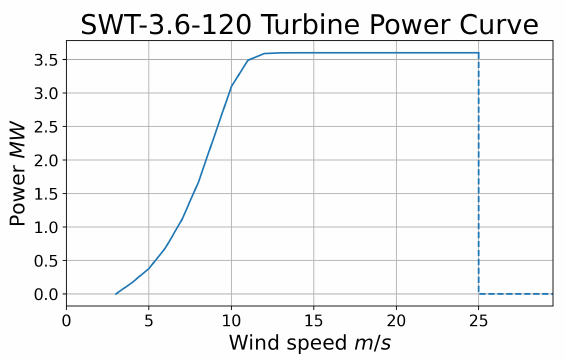
Figure 4. Power curve for the SWT-3.6-120 turbine. Provided by the windpowerlib python li- brary